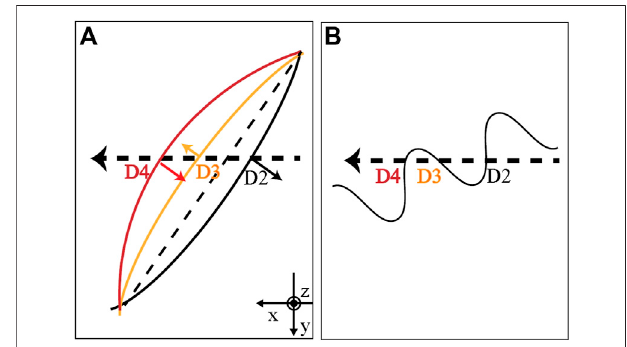
FIGURE 3 | Illustration of motion of the rear boundary of the reconnection exhaust in the x - y plane. The thick black arrowed line denotes the trajectory of the spacecraft passing through the rear boundary. (A) The fl apping motion of the rear boundary. The black curve indicates the position and shape of the rear boundary at D2 time. The orange and magenta solid curvesdenote the position and shape ofthe rear boundary at D3 and D4 time, respectively. The arrowed line indicates the direction of the fl ap, and its lengthdenotesthespeed.Thethinblackdashed linedenotestheundisturbed rear boundary of the reconnection exhaust. (B) The fold of the rear